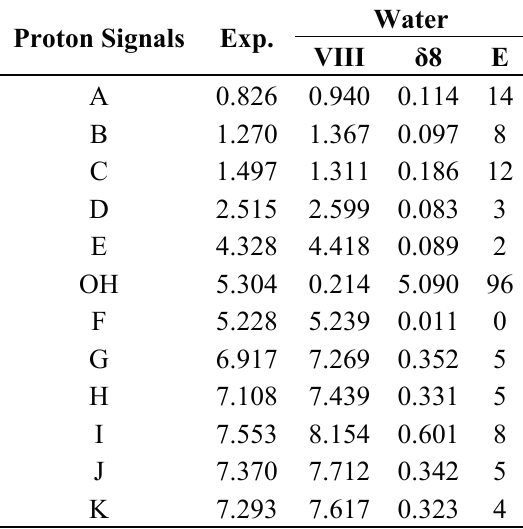
Table 2. Calculated and experimental data recorded at 293 K for losartan anion ( 1 ) Rotamer VIII (isomer syn ); the following parameters were determined for their proton groups: experimental (Exp.) and calculated values of the chemical shifts (VIII), absolute errors ( δ 8) and values of the relative percentage errors (E); calculated NMR shielding for proton H ref = 31.642 ppm for TMS (PBE1PBE/6-31G(d,p)/GIAO/CPCM; R 2 = 0.75, MAD = 0.77. Proton Signals